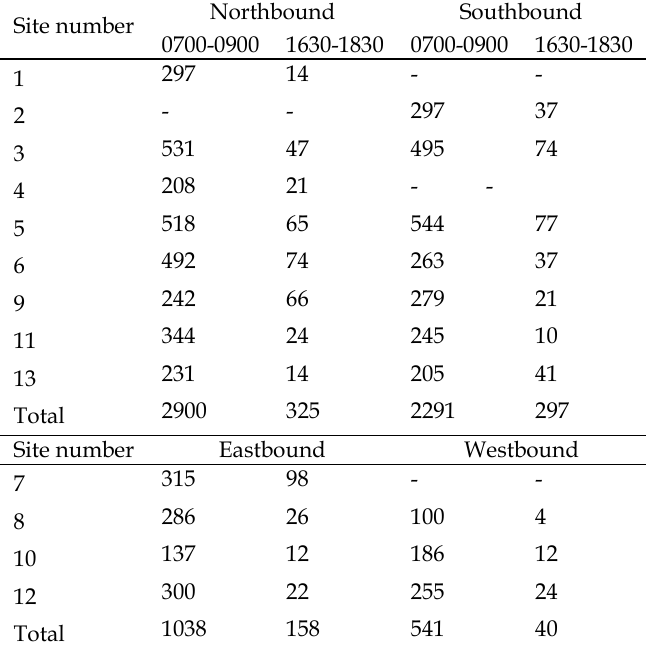
Table 3. Numbers of regular vehicles (N ≥ 30, σ≤ 10) in AM/PM peak